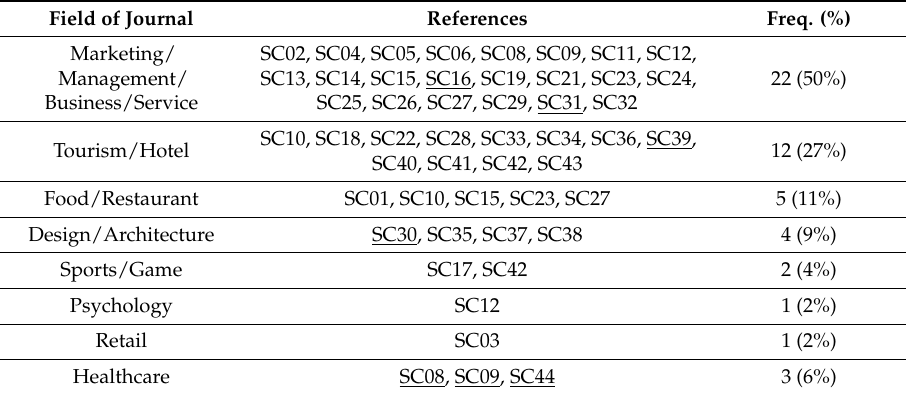
Table 2. Frequency analysis findings in fields of